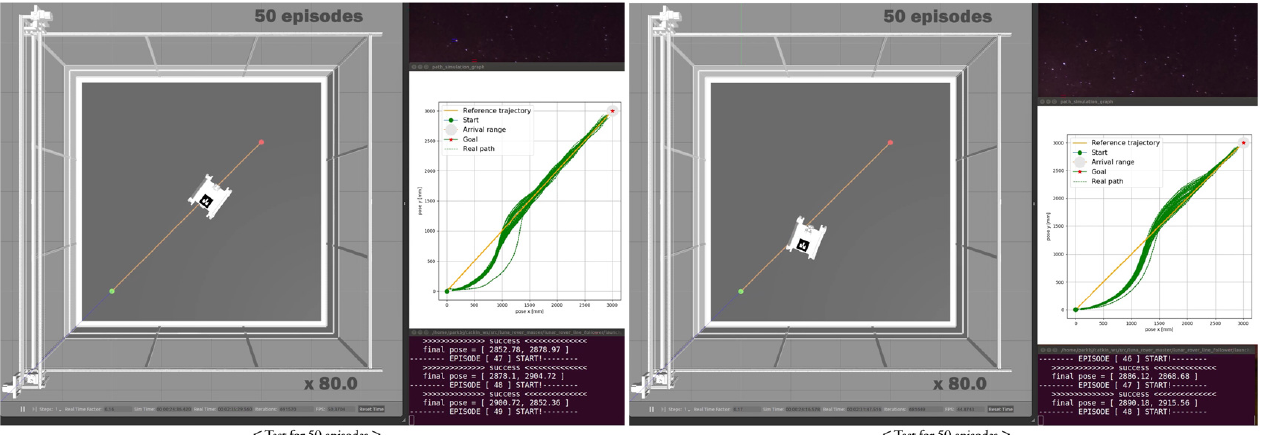
Figure 23. 50 test episodes performed in a normal state ( left ) and 50 test episodes performed in the case of a failure in the right steering motor ( right ).